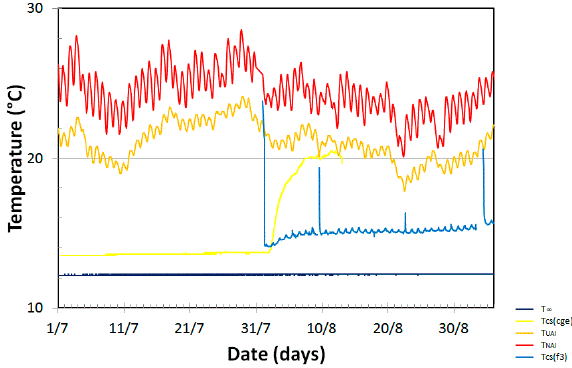
Figure 4. The temperature series used in the study are T UAI (recorded at the Buèges losses), T NAI (Hérault), T CS (recorded in CGE borehole until disconnection on 13 August 12h15 and at pump output), and T ∞ (recorded in the P7 borehole).